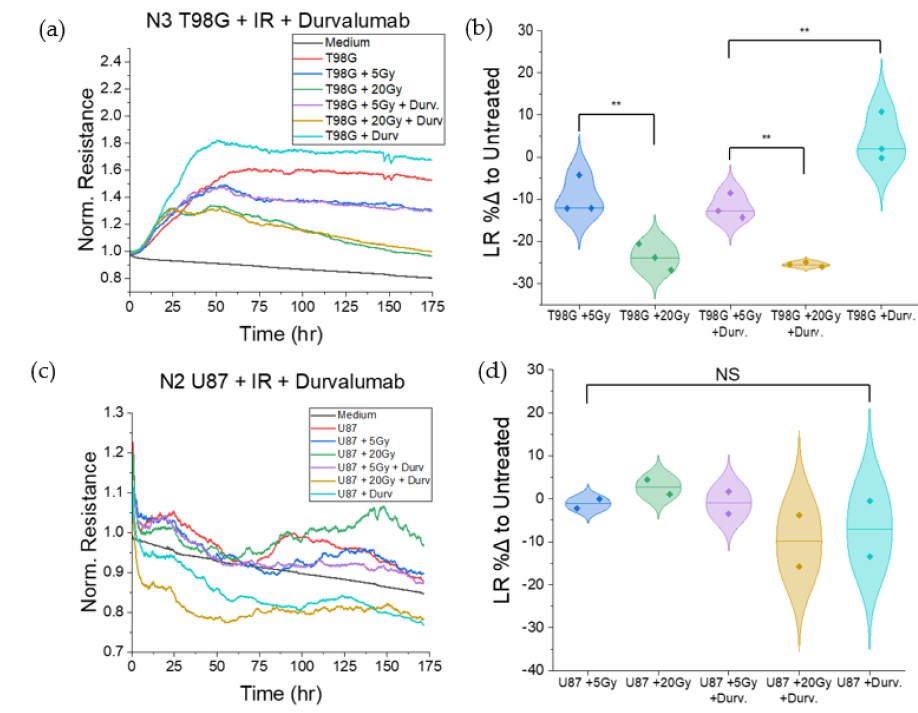
Figure 7. Late resistance-focused plots for T98G and U87 treated with radiation and durvalumab. ( a ) Representative normalized resistance plot for T98G treated with radiation and durvalumab over one week post-treatment. ( b ) Violin plots of comparison of late resistance (LR) between treated conditions in ( a ). ( c ) Representative normalized resistance plot for U87 treated with radiation and durvalumab over one week post-treatment. ( d ). Violin plots of comparison of late resistance (LR) between treated conditions in ( c ). The addition of durvalumab did not significantly change late resistance compared to irradiated conditions; however, cells treated with increased radiation doses showed decreased late resistance following the plateau region for T98G ( p < 0.01). ** p < 0.01, NS